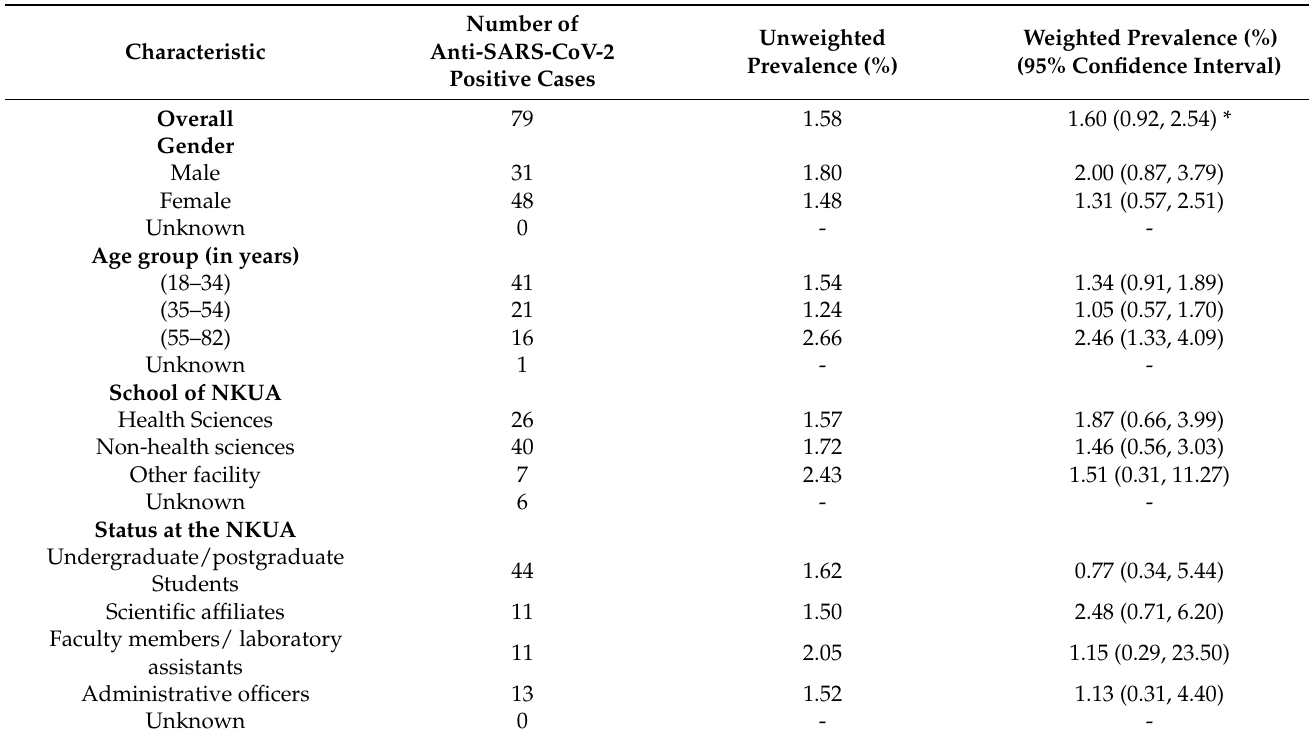
Table 2. Weighted prevalence for age and test performance of anti-severe acute respiratory syndrome coronavirus 2 (anti-SARS-CoV-2) nucleocapsid (N)-protein antibodies.